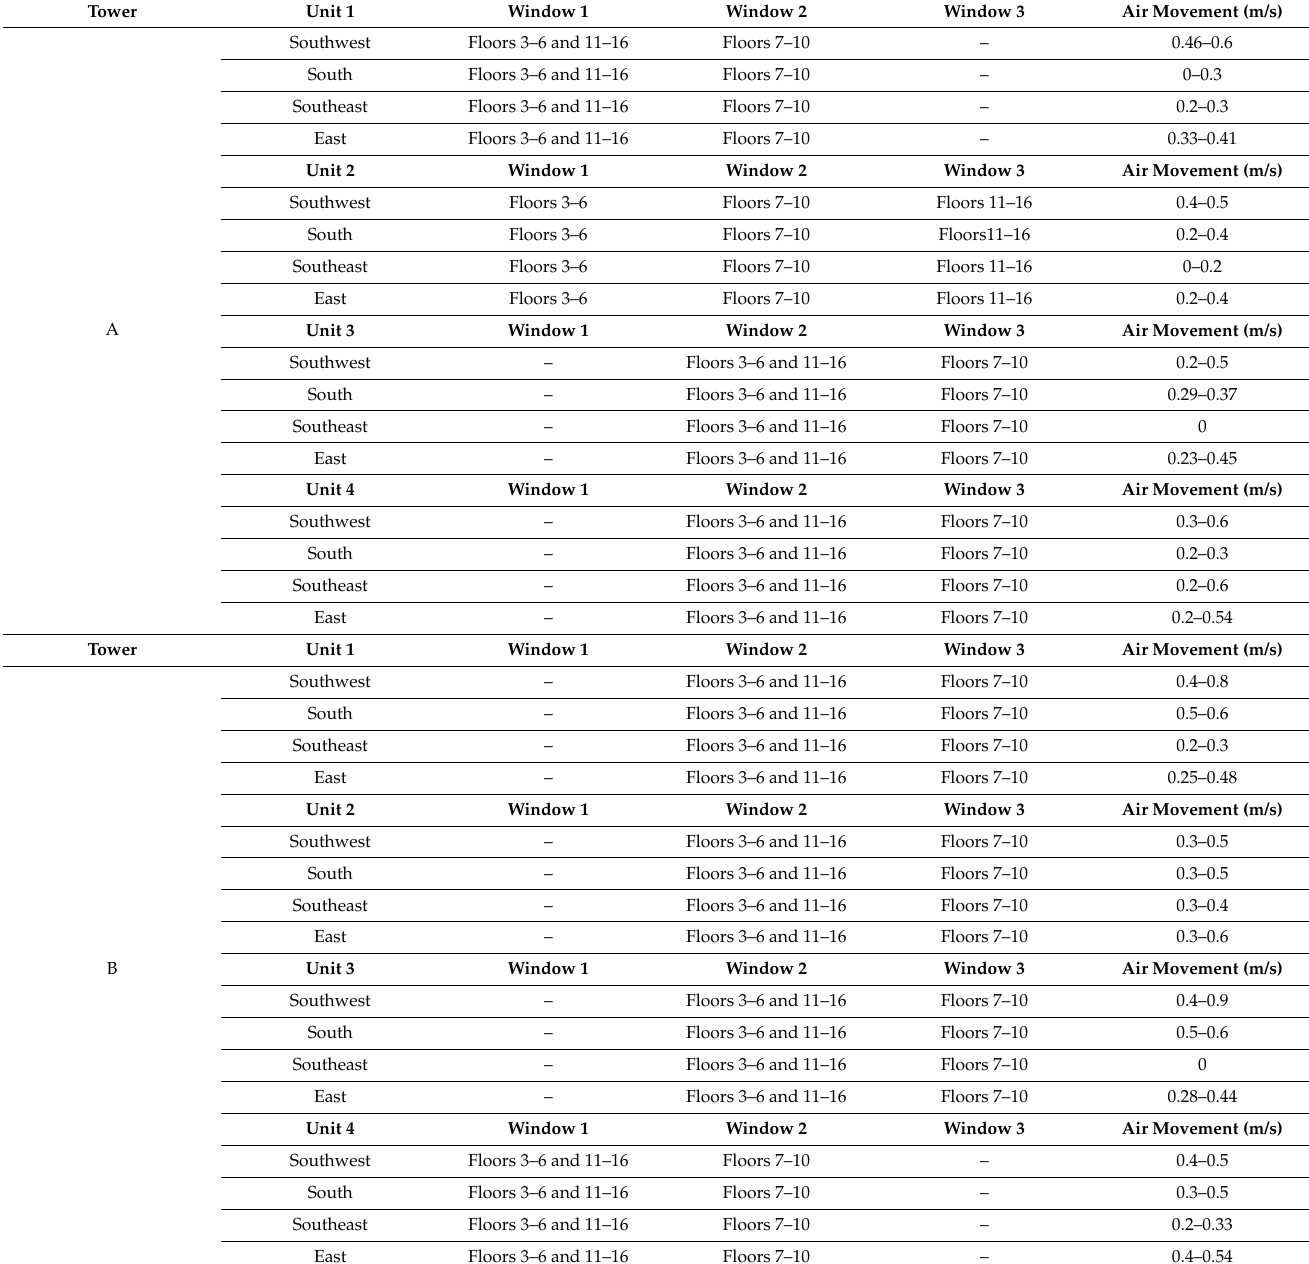
Table 12. First-phase data interpolation